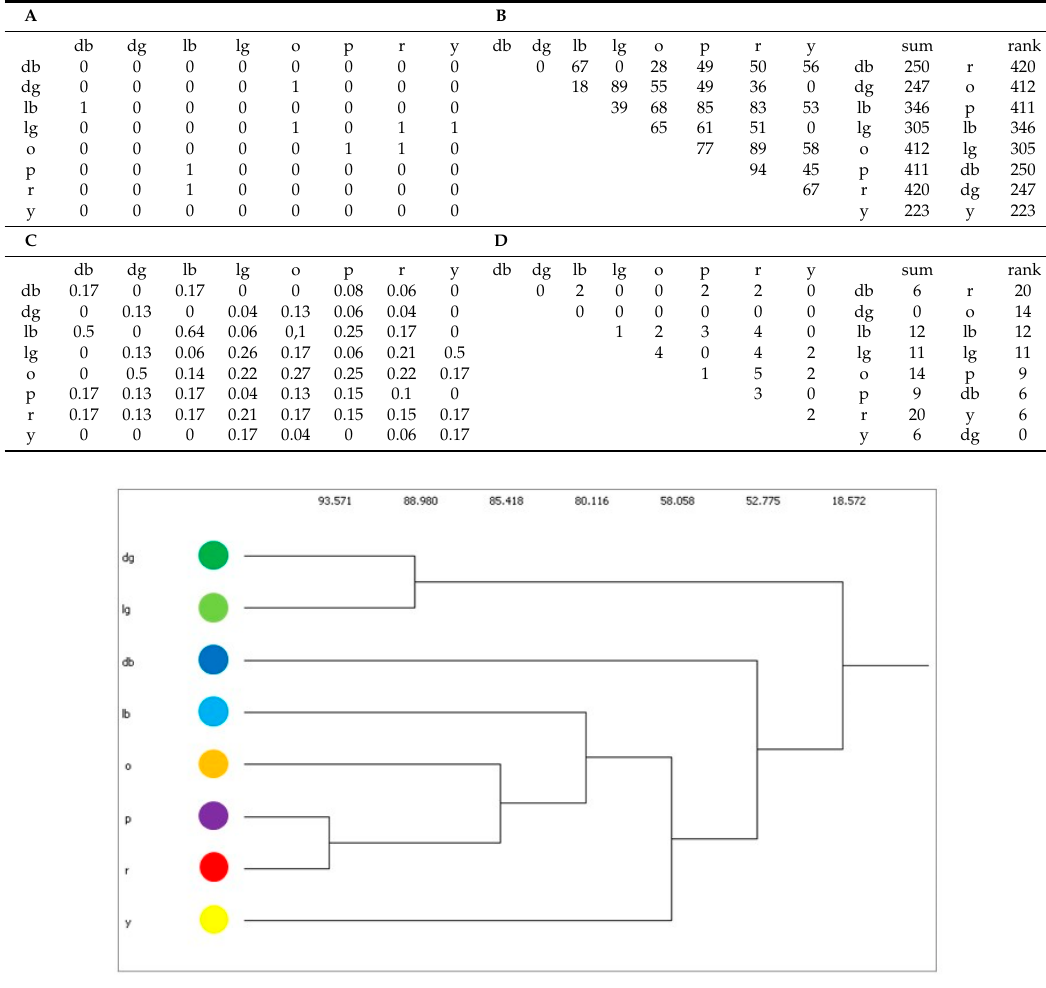
Figure 3. The REGE-based similarity dendrogram for the toy network, shown in Figure 1. The x -axis shows the similarity of network positions: The path is shorter between similar nodes. Nodes are marked by both colors and abbreviations (dg, dark green; lg, light green; db, dark blue; lb, light blue; o, orange; p, purple; r, red; y, yellow).